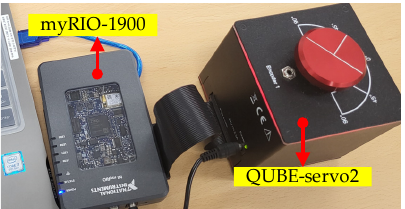
Figure 2. Servo system implementation for the experimental